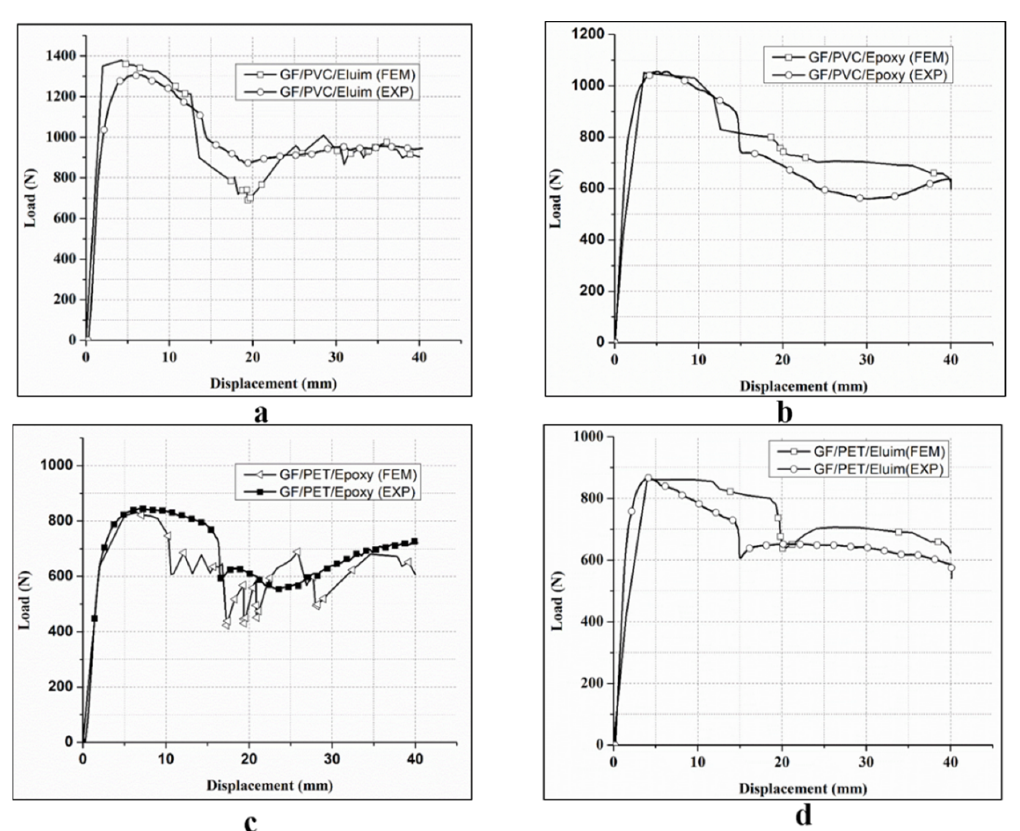
Figure 5. Load–displacement curves for flexural tests of GF/PVC/Elium ( a ), GF/PVC/Epoxy ( b ), GF/PET/Epoxy ( c ), and GF/PET/Elium ( d ) sandwich composites.